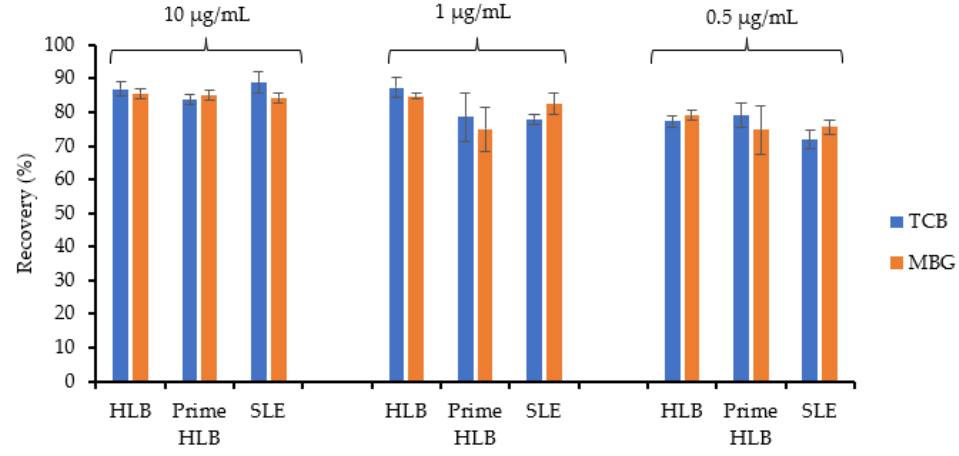
Figure 5. Percent recoveries of CTS spiked in urine after extraction with HLB, Prime HLB and SLE cartridges determined by HPLC-PDA. The analyses were carried out in triplicate ( n = 3). Overall, HLB had the highest recovery compared to the other two cartridges. It was observed that the CTS recovery decreased for urine spiked with lower concentrations of CTSs vs. those spiked with higher concentration of CTSs. CTSs were successfully extracted from rat urine samples using HLB cartridges with recoveries >80%. The best recoveries from SPE were achieved when washing was carried out with 5% methanol, and elution with 100% methanol. HLB was chosen for the extraction of CTS from rat urine since it yielded higher recovery, produced consistent and reproducible results, and the extraction procedure was simple and efficient. After figuring out that HLB was a suitable extraction cartridge for maximum CTS recovery from urine, it was tested for reproducibility using three different cartridges at lower concentrations (1 and 10 ng/mL) (Figure 6).